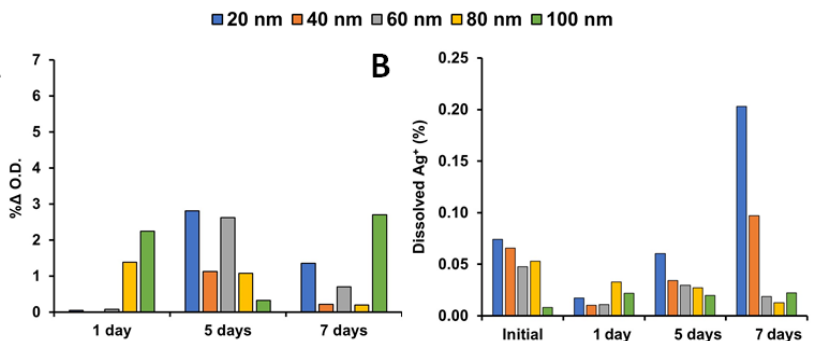
Figure 2. Representative |% change| in the ( A ) O.D. of Ag–SOA–PC–HT nanoparticles (20–100 nm) and ( B ) ICP-MS analysis of Ag + ion release from 1 mL samples of Ag–SOA–PC–HT samples (20–100 nm) at 1-day, 5-days, and 7-days post-synthesis in